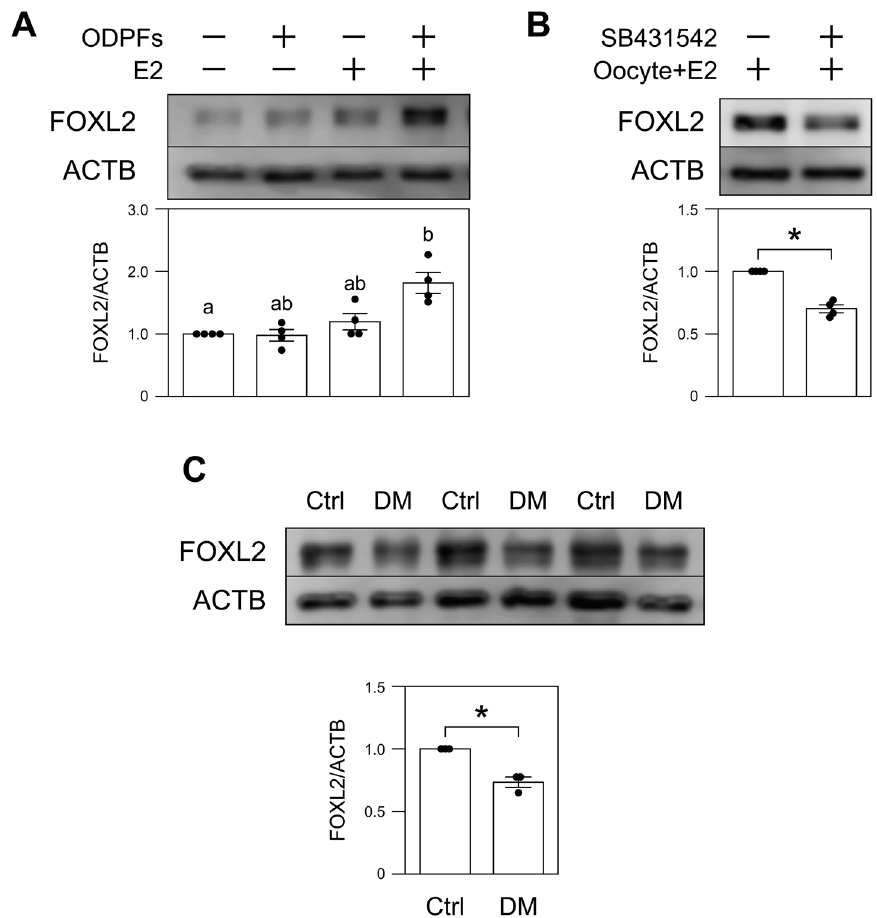
Figure 4. Effects of BMP15 and GDF9 signals on FOXL2 expression in MGCs. ( A ) MGCs were cultured with or without recombinant BMP15/GDF9 (ODPFs) and E2 for 24 h (n = 4). ( B ) MGCs cultured with both oocytes and E2 were treated with or without an inhibitor of ALK5, SB431542 for 24 h (n = 4). ( C ) Comparison of the expression levels of FOXL2 protein between MGCs of Bmp15 −/− / Gdf9 +/− mice (DM) and those of littermate control Bmp15 +/− / Gdf9 +/− mice (Ctrl) (n = 3 each). The expression of FOXL2 protein was examined by western blotting (upper panel) and band intensities were quantified (lower panel). Asterisks or different letters (a and b) denote significant differences ( p <